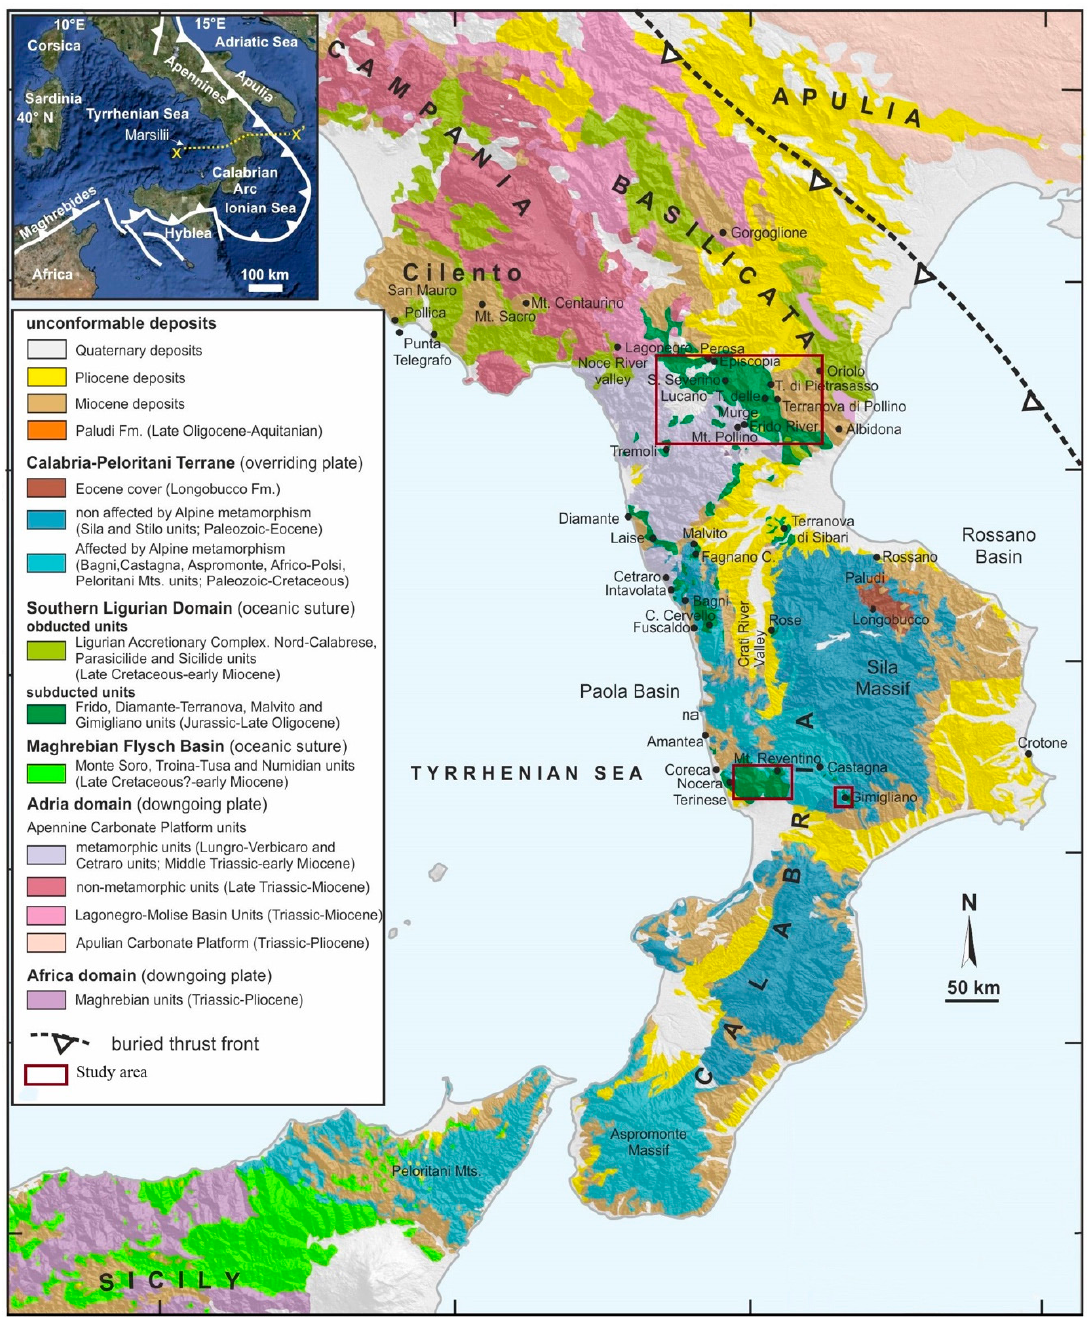
Figure 2. Geological sketch map of the Southern Apennines-Calabria-Peloritani chain and location of the study areas (modified after [50]).